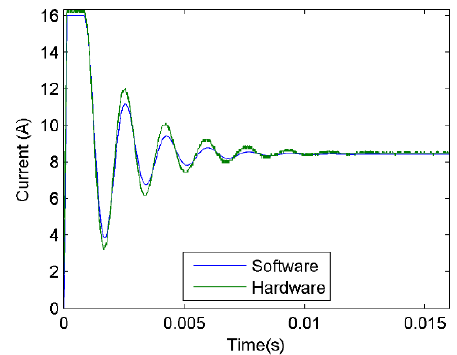
Figure 20. Current response from the boost convertor emulator (BCE).